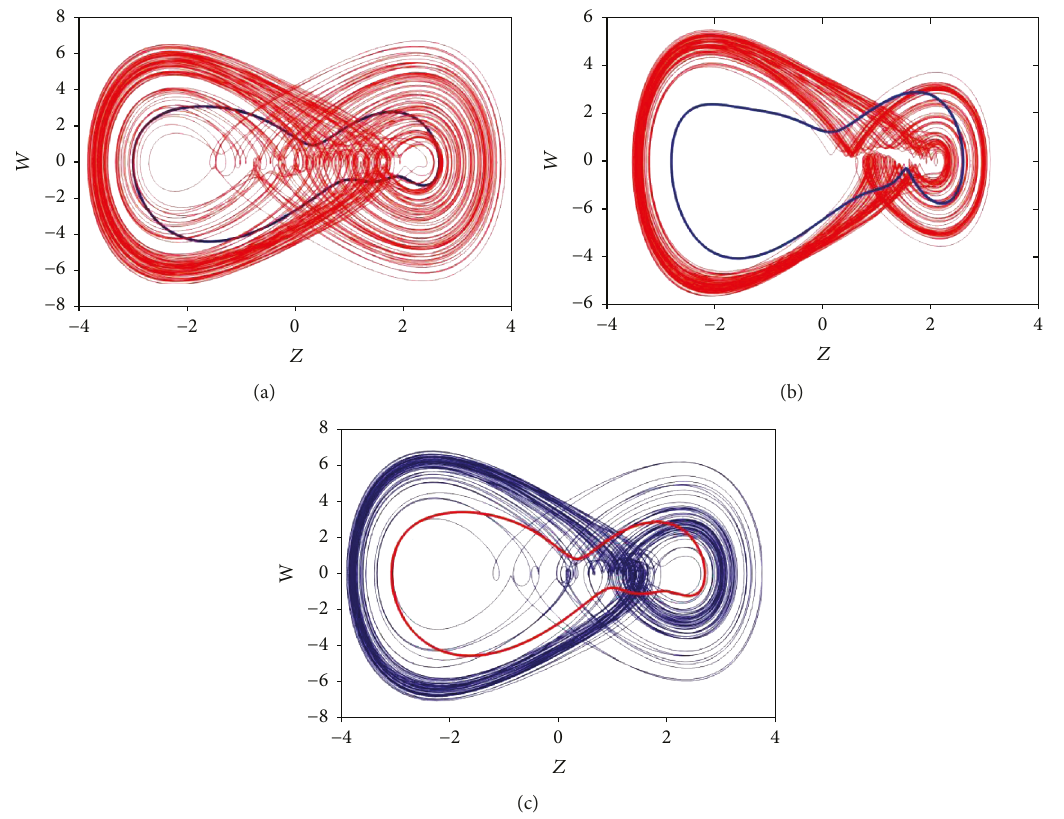
Figure 5: Coexisting attractors exhibited by the FOPCC system. (a) Coexisting attractor and period-1 limit cycle for d = 9 5 with initial conditions − 3 59, − 2 73, − 1 34, 2 86, 1 shown as blue plot and with initial conditions 1, 1, 1, 1, 1 shown as red plot. (b) Coexisting attractor and period-1 limit cycle for d = 8 with initial conditions 1 53, − 5 49, 2 39, − 1 74, 1 shown as blue plot and with initial conditions 1, 1, 1, 1, 1 shown as red plot. (c) Coexisting attractor and period-1 limit cycle for d = 10 with initial conditions 1 53, − 5 49, 2 39, − 1 74, 1 shown as blue plot and with initial conditions 1, 1, 1, 1, 1 shown as red